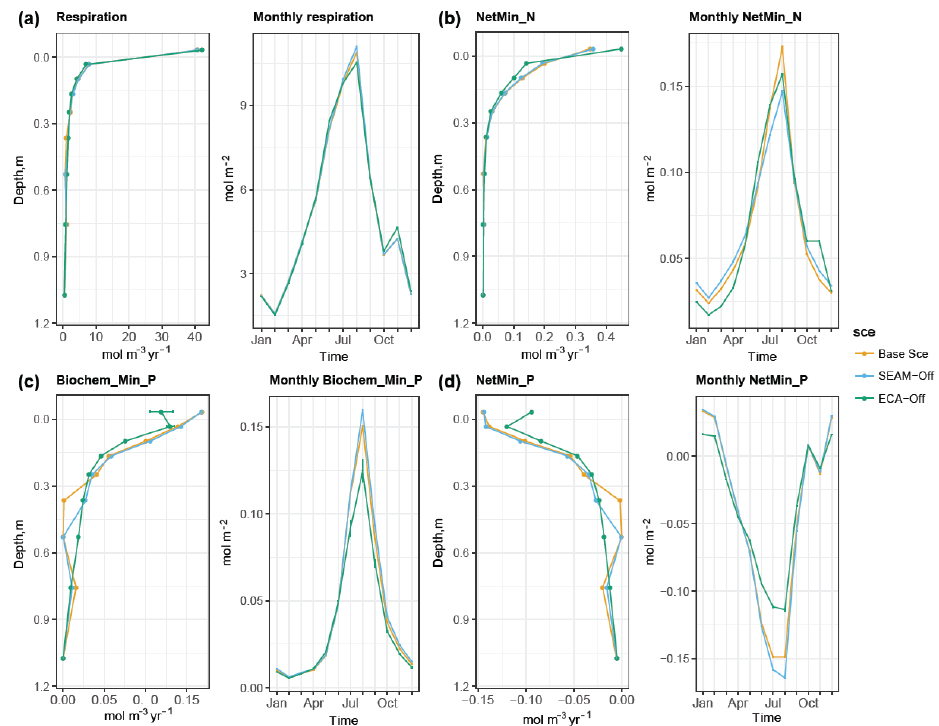
Figure 5. Simulated seasonal and vertical distribution of (a) respiration, (b) net N mineralisation, (c) biochemical P mineralisation and (d) net P mineralisation at the study site at 1m soil depth. Points represent the mean values and error bars represent the standard deviations, both calculated using data from the last 10 years of model